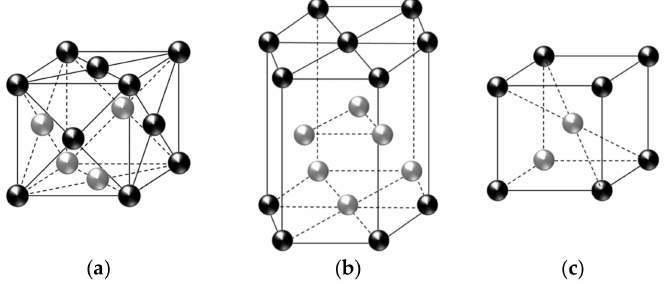
Figure 1. Micro-structure of crystal lattices: ( a ) γ -austenite; ( b ) ε -martensite; ( c ) α ’-martensite.